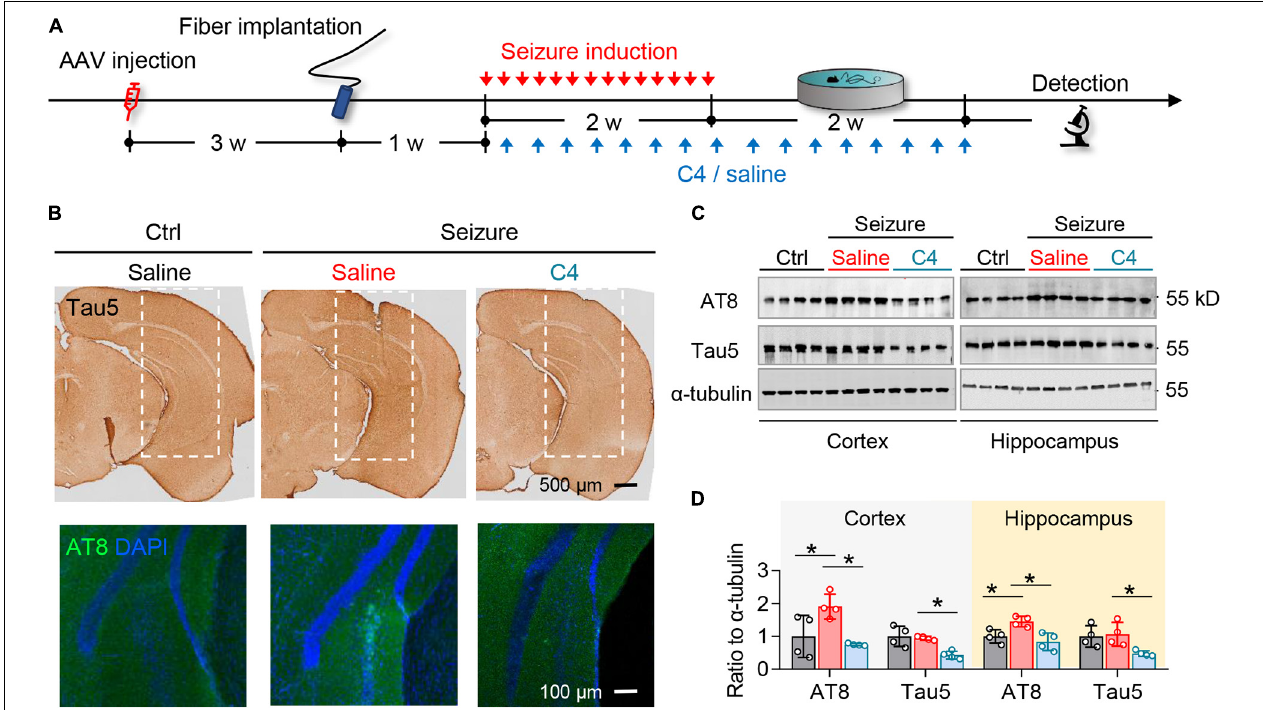
FIGURE 4 | C4 selectively facilitates tau degradation in the optogenetically inducible mouse model of epilepsy. (A) Experimental procedure of virus injection, seizure induction, C4 administration, and behavioral tests. (B–D) C4 administration diminished the repeated seizure-induced elevation of total tau and phospho-tau levels in hippocampus and cortex measured by immunostaining (B) and Western blotting (C,D) . n = 4 mice in each group. One-way ANOVA followed by Tukey multiple-comparisons tests, * p < 0.05. Scale bars were as indicated in each panel. Values are presented as the mean ±